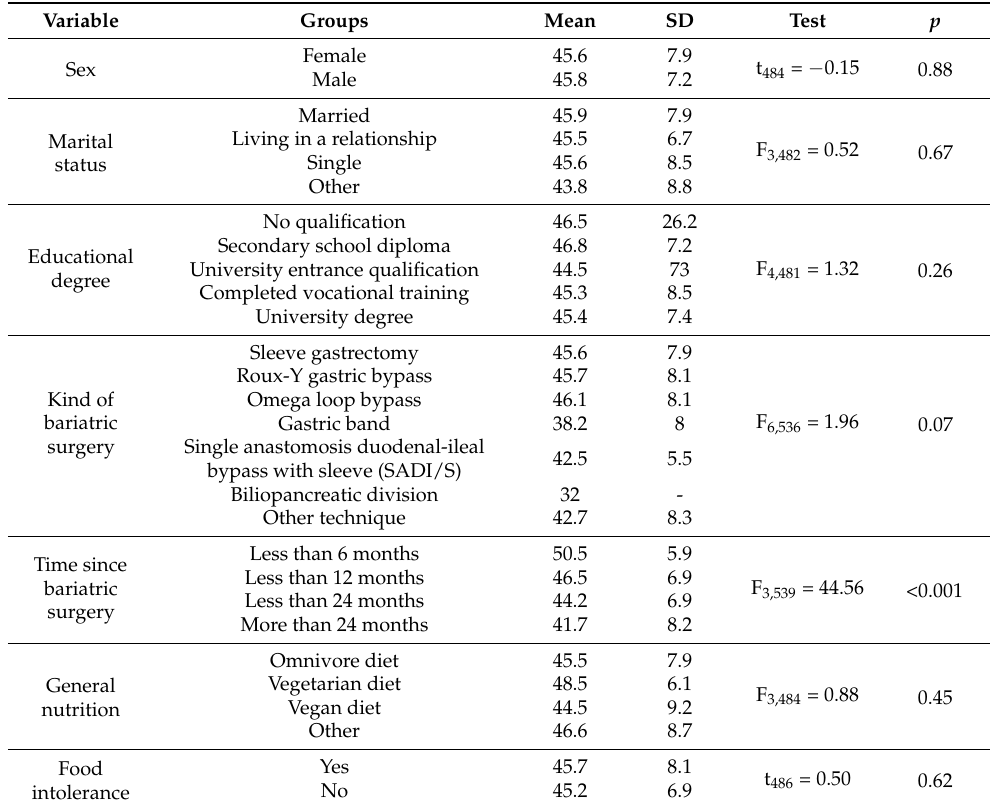
Table 3. DBI-S score and relation to sociodemographic, medical and nutrition variables.